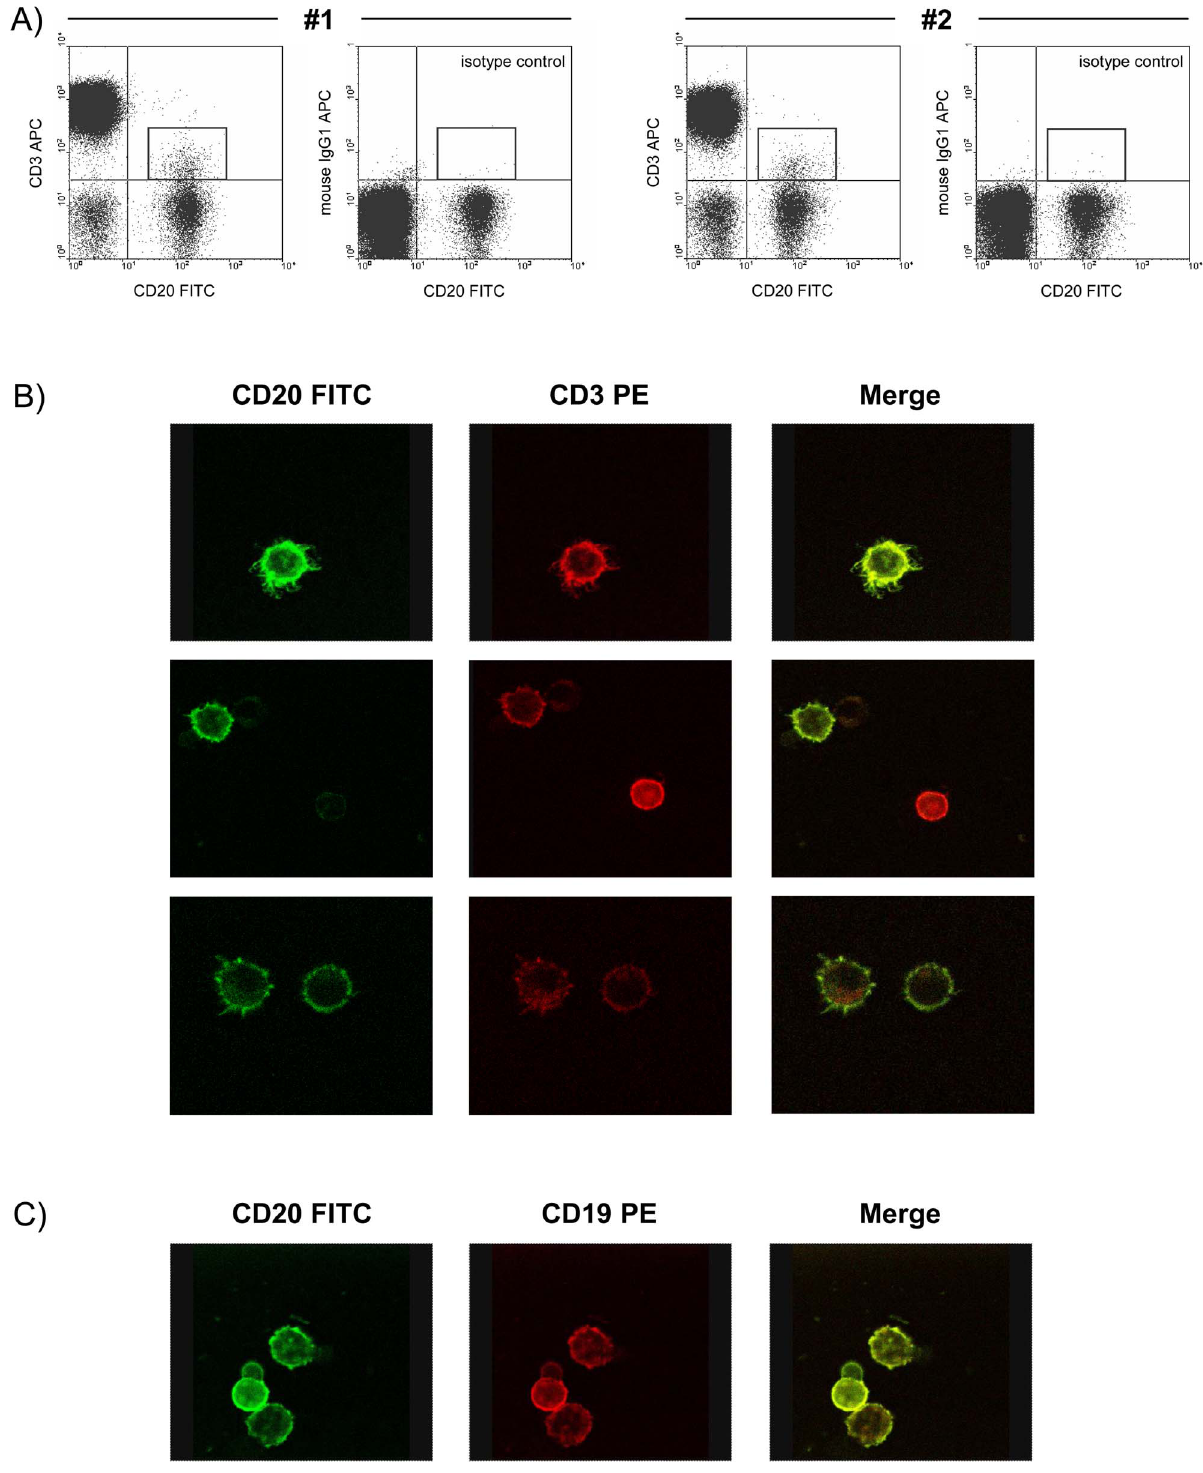
Figure 2. Co-expression of CD3 and CD20 on the cell surface is not a staining artifact. (A) Shown is the presence of CD3 low CD20 + cells after overnight storage of blood samples at 4 u C for two representative patients ( # 1 and # 2, left). Staining of blood cells with the respective allophycocyanin (APC)-labeled mouse IgG1 isotype control excludes an artifact caused by the fluorochrome APC ( # 1 and # 2, right). (B) Simultaneous expression of CD20 and CD3 on the surface of MACS-purified CD20 + lymphocytes is demonstrated for one representative donor by single cell analysis using confocal laser microscopy. (C) Confirmation of concomitant CD20 (FITC) and CD19 (PE) expression on MACS-purified CD20 + B cells served as positive control. Whole blood samples were stored overnight at 4 u C before PBMC isolation and MACS analysis.